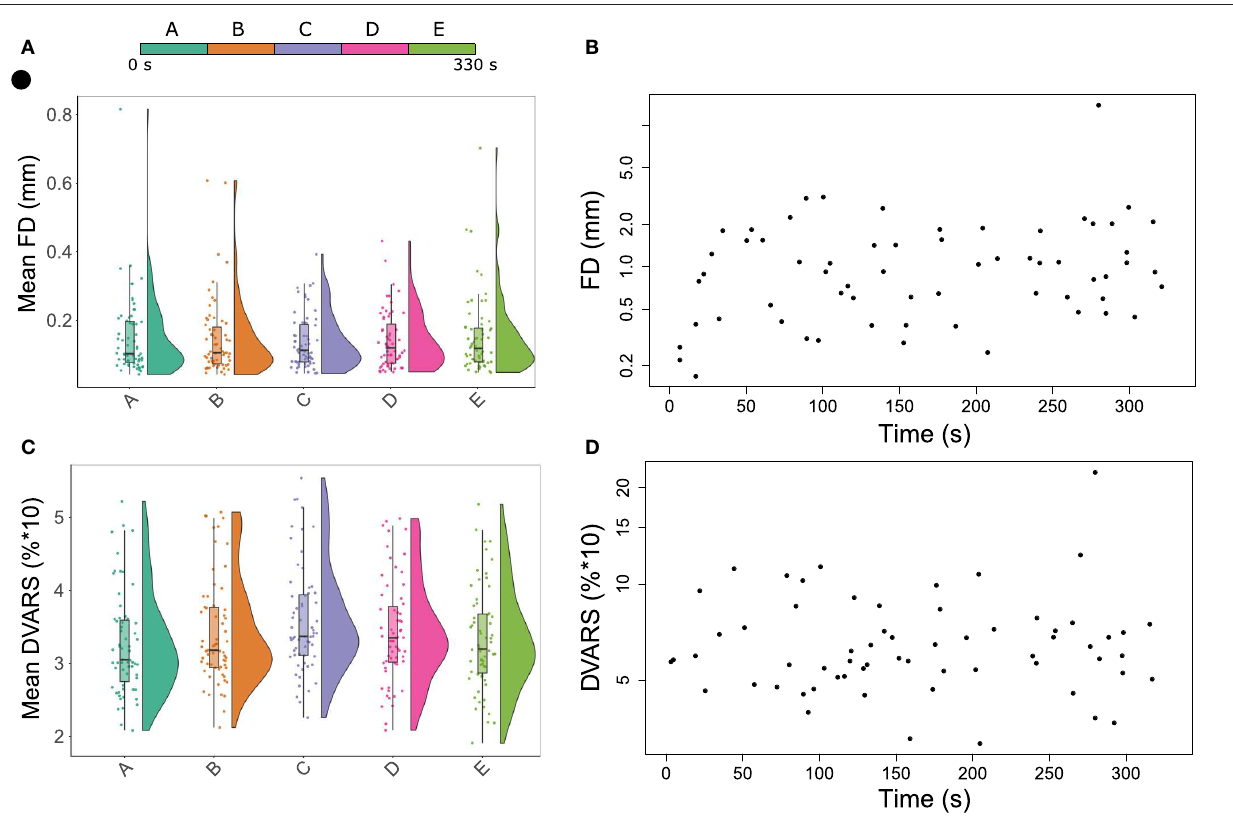
FIGURE 1 | Raincloud plots showing the distribution of mean head motion metrics (framewise displacement in (A) DVARS in (C) for each segment of the resting-state functional MRI scan. In Figures 1B,D , each point represents the maximum head motion value across the full scan (from one patient) measured using framewise displacement (B) and DVARS (D) , plotted against